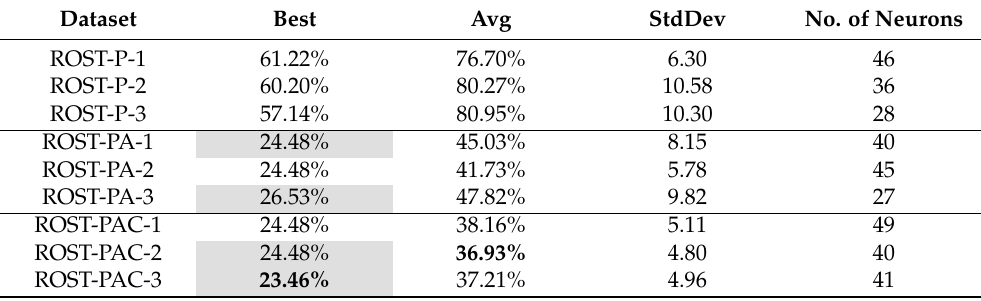
Table 11. ANN results on the considered datasets. On each set, 30 runs are performed by ANNs with the hidden layer containing from 5 to 50 neurons. The number of incorrectly classified data is given as a percentage (the best results obtained by ANN on any ROST-*-* dataset representation are in bold). Best stands for the best solution (out of 30 runs on each of the 46 ANNs), Avg stands for Average (over 30 runs), StdDev stands for Standard Deviation , and No. of neurons stands for the number of neurons in the hidden layer of the ANN that produced the best solution. The best result obtained by ANN compared to all methods for a given ROST-X-n dataset representation is in a gray cell. Dataset Best Avg StdDev No. of Neurons ROST-P-1 61.22% 76.70% 60.20% 80.27%